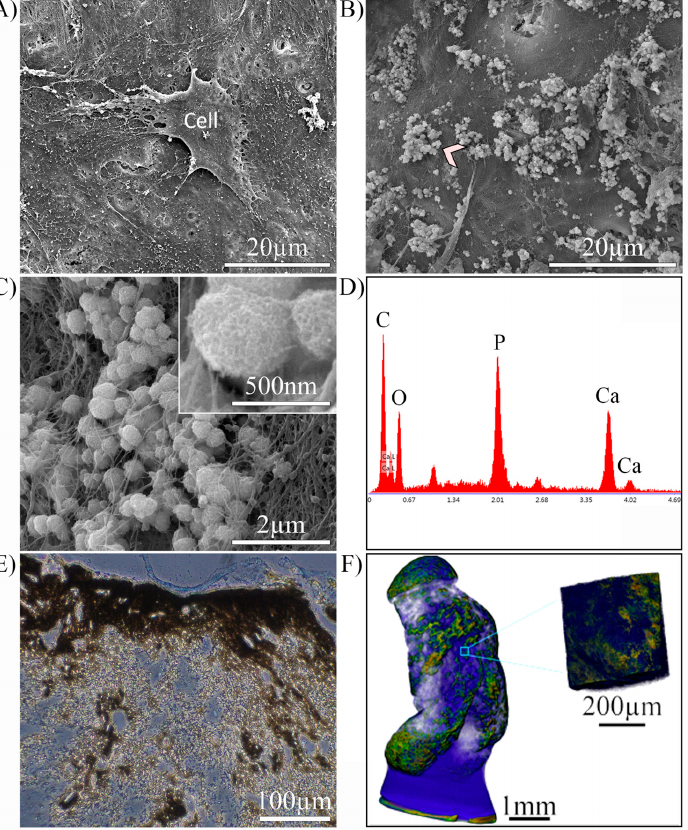
Figure 6. Characterization of MC3T3-E1 cell-mediated mineralization of DCF 2:1 SS gels at day 35 in osteogenic medium. ( A ) SEM micrograph of a seeded MC3T3-E1 pre-osteoblastic cell cultured in osteogenic medium. ( B ) SEM micrograph of mineralized matrix (chevron). ( C ) Higher magnification of the matrix area indicated by the chevron in ( B ). Inset, higher magnification images of the spherulitic-shaped apatite mineral amongst the fibres. ( D ) EDX analysis of the area indicated by the chevron in ( B ) detecting the presence of calcium and phosphorus. ( E ) von Kossa staining for minerals in representative histological sections of seeded gels. Blue spots are cells while brown/black areas are minerals. ( F ) Micro-CT 3D reconstruction of a mineralized gel at day 35. A mineralized phase (green) can be distinguished from organic phase (blue) within the gel. Inset, higher magnification of a partially mineralized volume of the